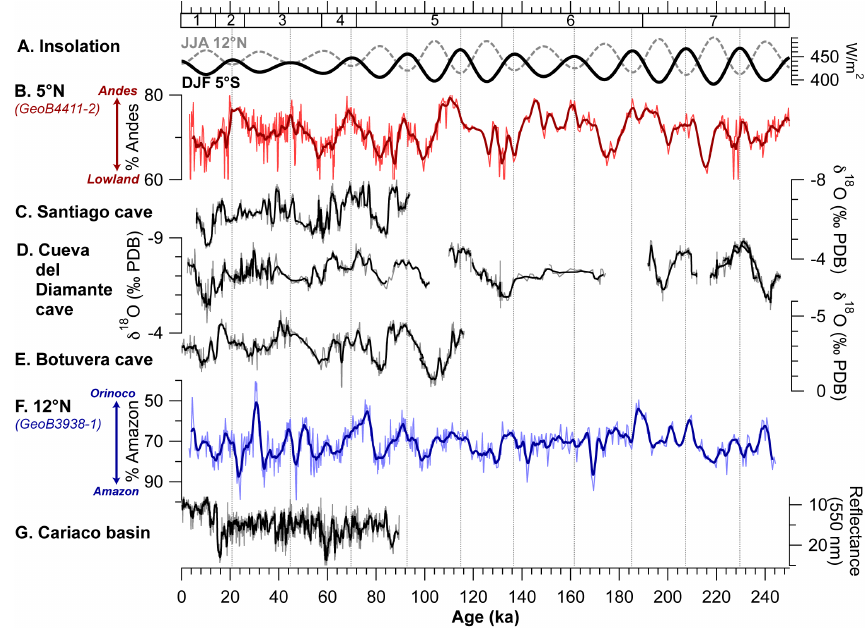
Fig. 8. Comparison with published records. (A) December-January-February (DJF, black line) and June-July-August (JJA, dashed grey line) insolation curves (Laskar et al., 2004). (B) %-Andes record from the core at 5 ◦ N (GeoB4411-2, same as in Fig. 6c). (C) – (E) Speleothem δ 18 O records from Santiago cave (in C ) (Mosblech et al., 2012), Cueva del Diamante cave (in D ) (Cheng et al., 2013) and Botuverá cave (in E ) (Cruz et al., 2005). (F) %-Amazon record from the core at 12 ◦ N (GeoB3938-1, same as in Fig. 6e but on a reversed scale). (G) Reflectance from ODP site 1002C from the Cariaco Basin (Peterson et al., 2000). Grey vertical dotted lines highlight DJF (JJA) insolation maxima (minima). See Fig. 1 for locations of published records. Marine isotope stages are indicated at the top of (A)